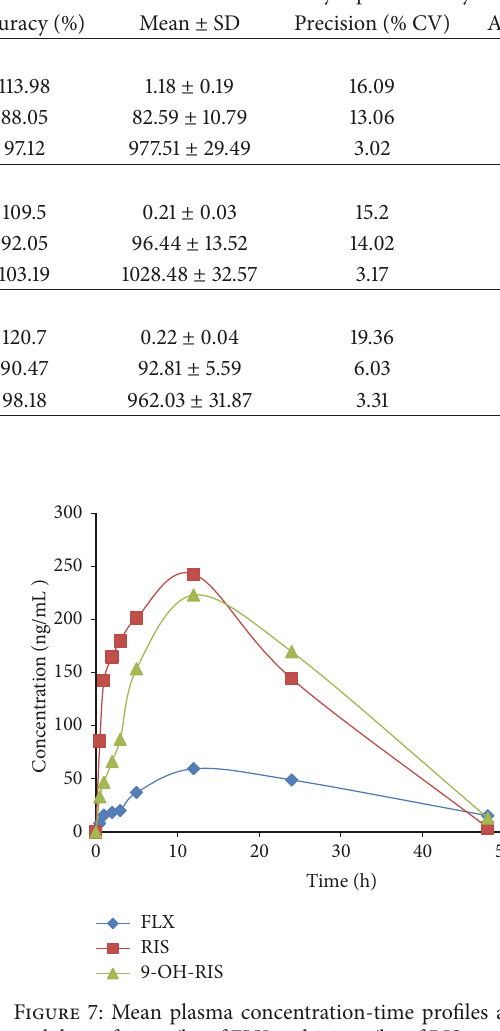
Table 2: Intraday and interday precision and accuracy of FLX, RIS, and 9- OH-RIS in rat plasma. Nominal conc. (ng/ml)